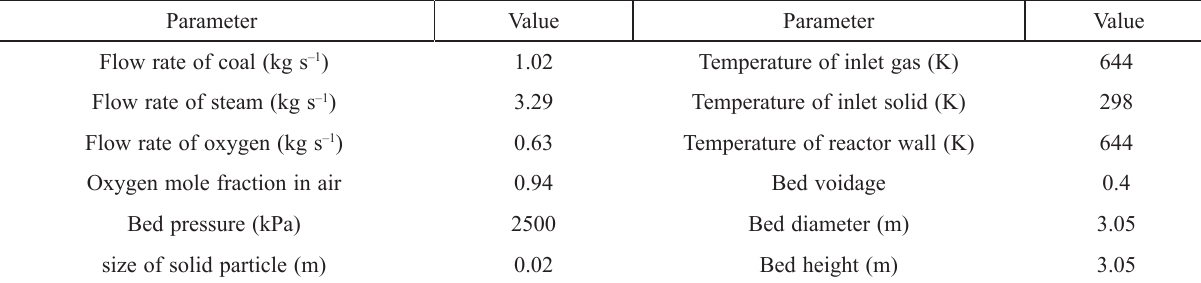
Table 3 – Lurgi gasifier operating conditions of Westfield unit in Scotland for Pittsburgh No. 8